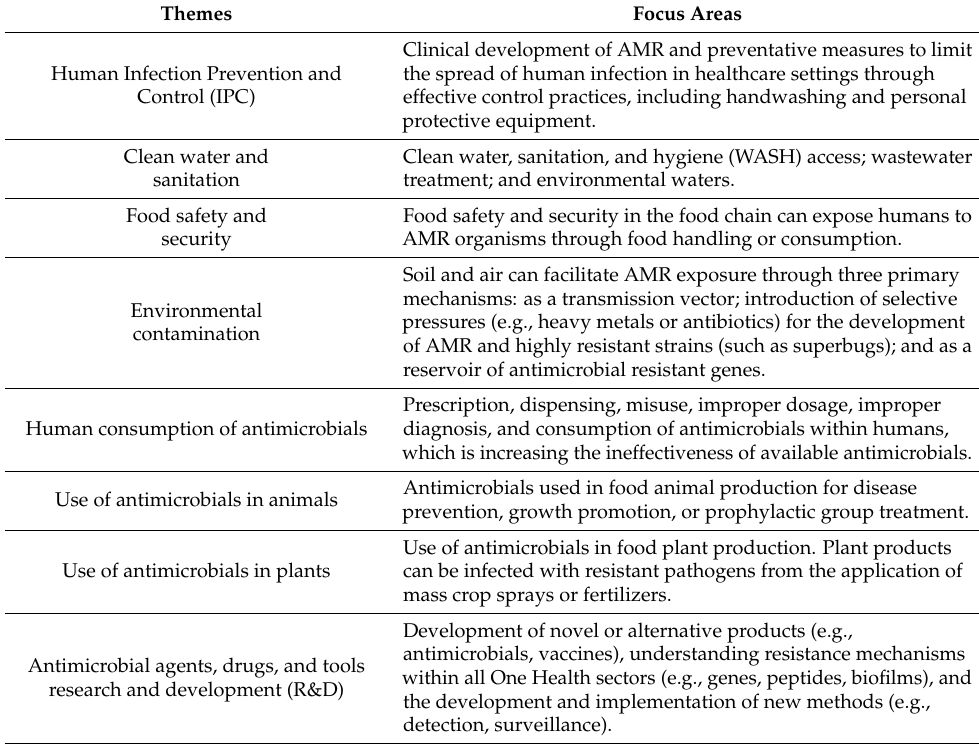
Table 2. Antimicrobial resistance stewardship themes and focus